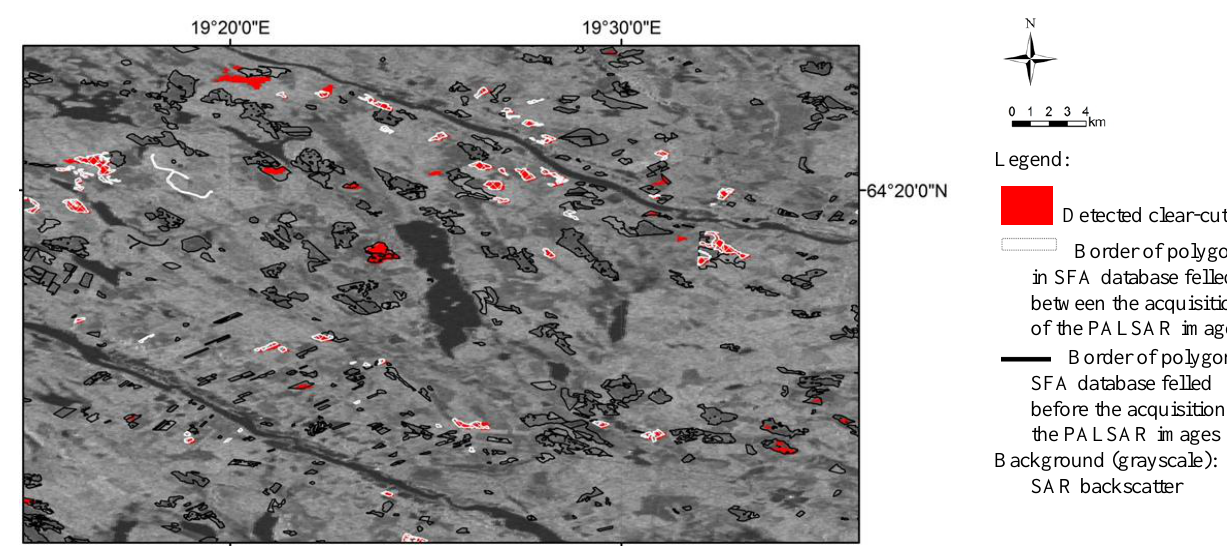
Figure 6. Clear-cuts detected in an ALOS PALSAR K&C strip image pair (in red). White polygons indicate clear-cuts recorded in the SFA database for the time frame of the PALSAR image acquisitions. Black polygons indicate clear-cuts recorded in the Swedish Forest Agency (SFA) database as felled before the acquisition of the PALSAR image